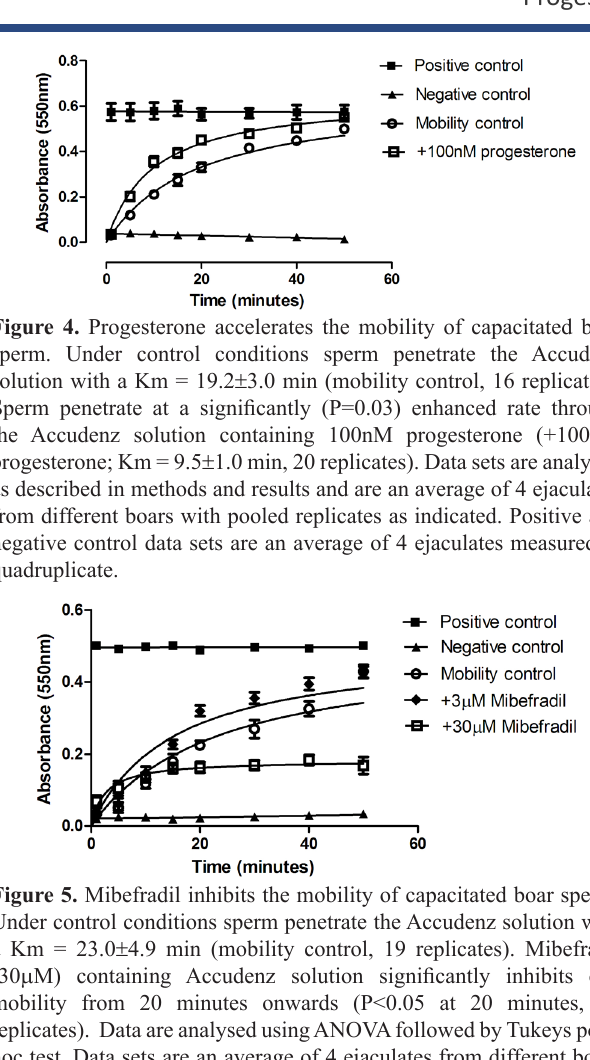
Figure 8. Sperm capacitation is associated with changes in protein phosphotyrosine content. Western blot demonstrating the change in protein phosphotyrosine pattern induced by capacitation of sperm from 4 different ejaculates from consecutive weeks from different boars. 1×10 8 sperm cells were incubated in either non-capacitating or capacitating conditions for 3 hours and subsequently pelleted at 17000×g then heated at 95 ° C in Laemmli sample buffer and frozen for subsequent use in SDS-PAGE/Western blot. Lanes 1&5, 2&6, 3&7 and 4&8 are